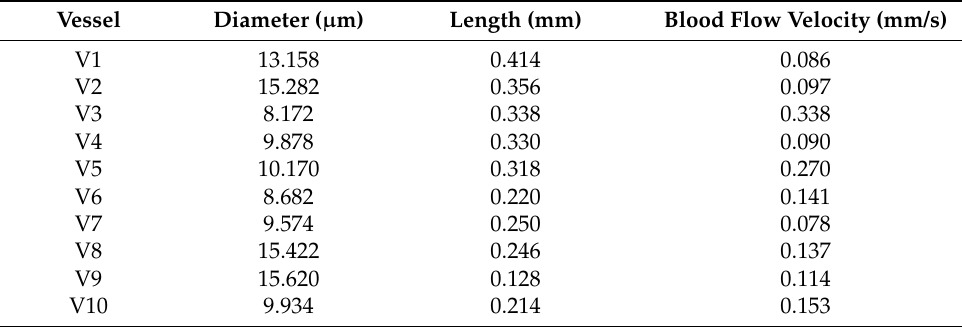
Table 1. Diameter, length, and blood flow velocity of conjunctival